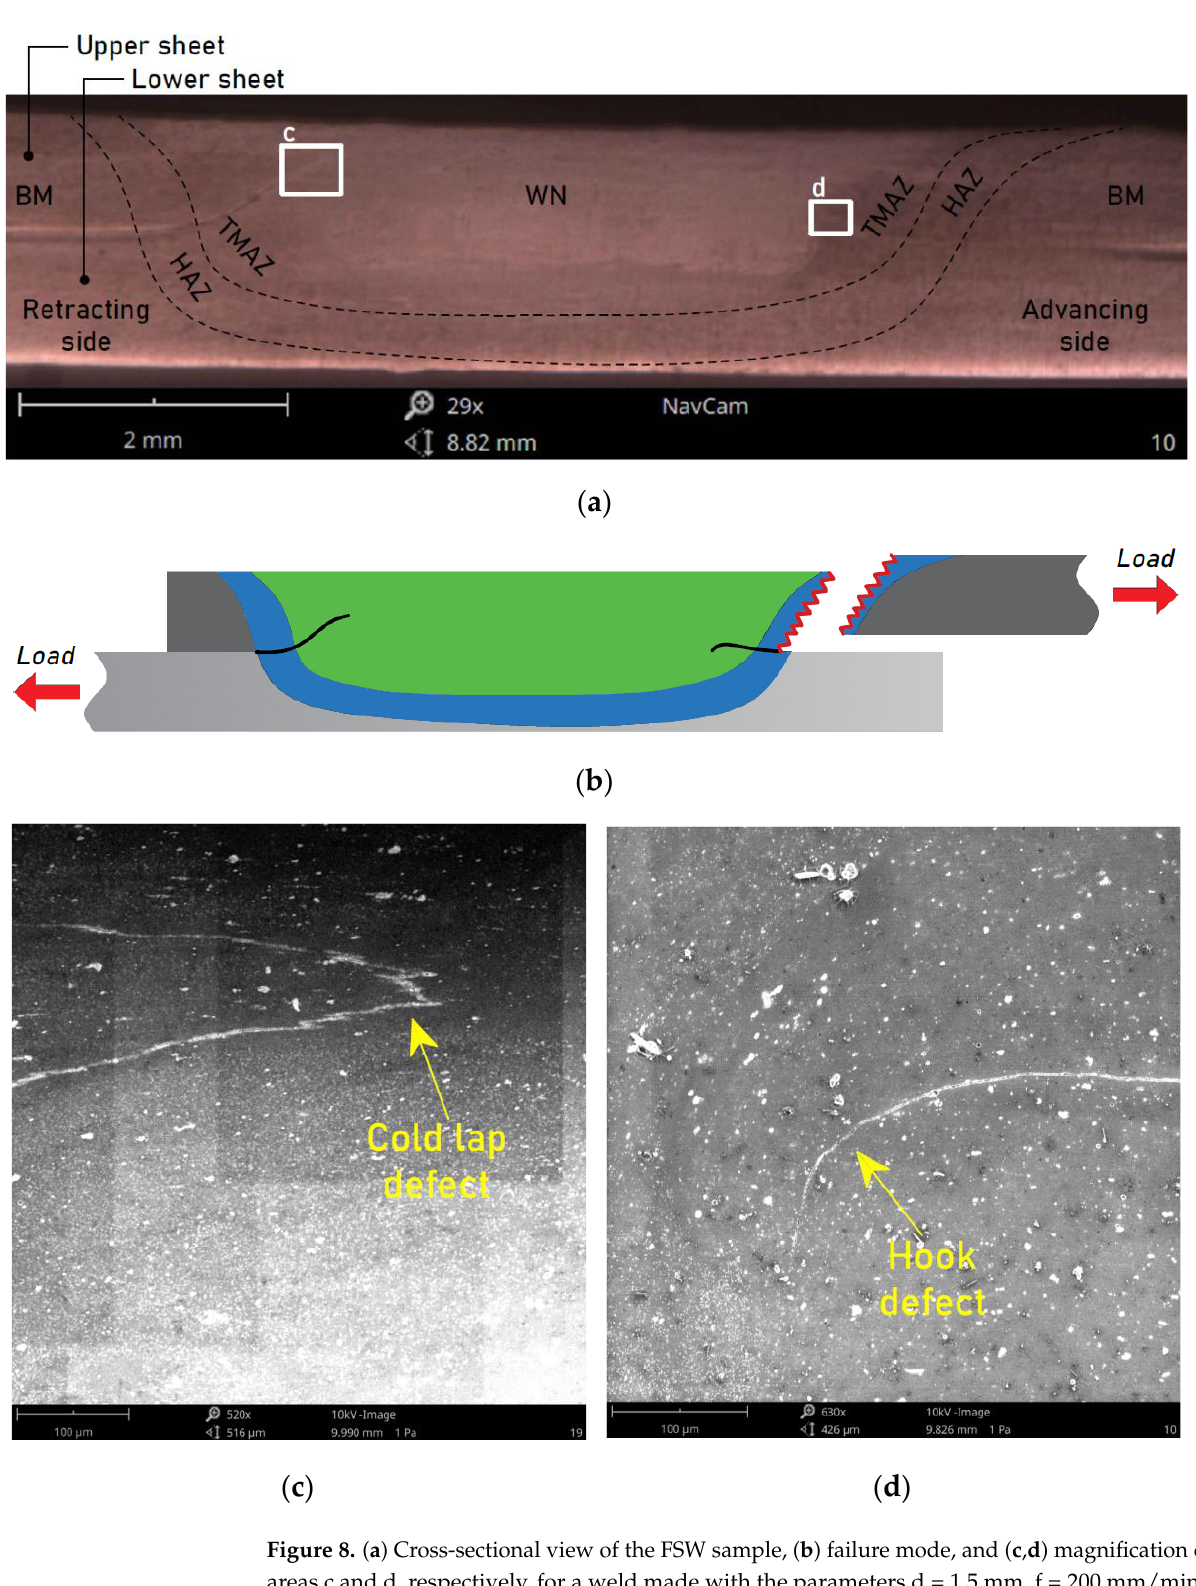
Figure 8. ( a ) Cross-sectional view of the FSW sample, ( b ) failure mode, and ( c , d ) magnification of the areas c and d, respectively, for a weld made with the parameters d = 1.5 mm, f = 200 mm/min, and n = 1200 rpm.